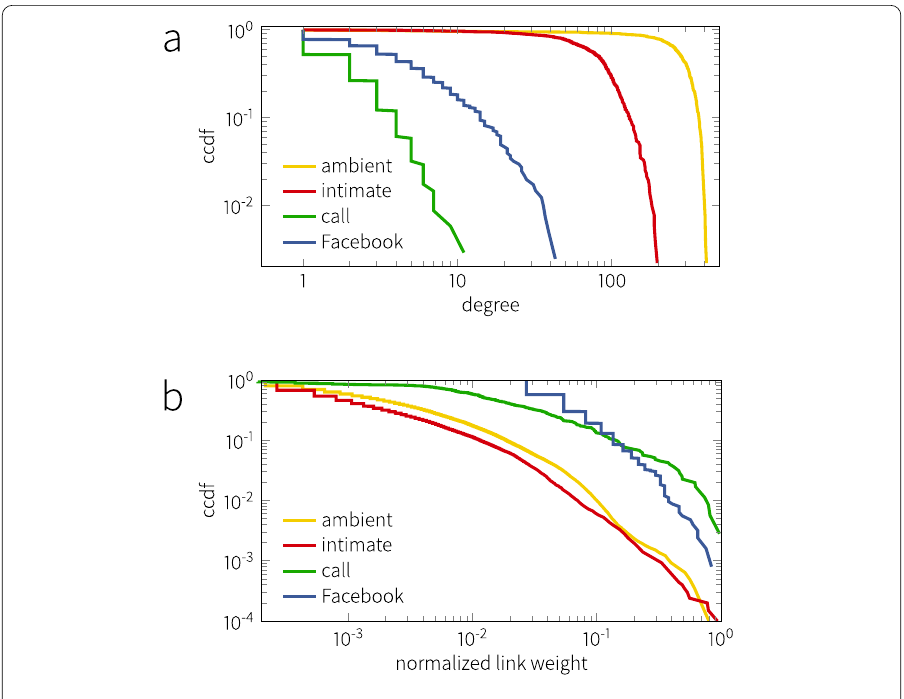
Figure 5 Degree and link weight distributions in the four contact networks. (a) Complementary cumulative distribution function (ccdf) of the degrees in the proximity and communication networks. (b) Ccdf of normalized link weights (number of contacts observed on the